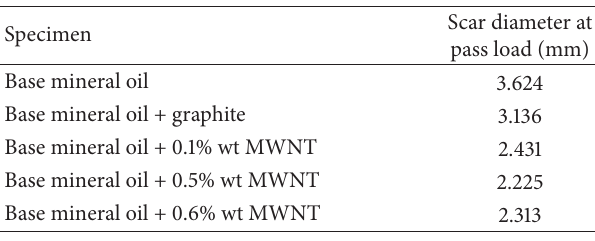
Table 3: Scar diameters of different specimens.